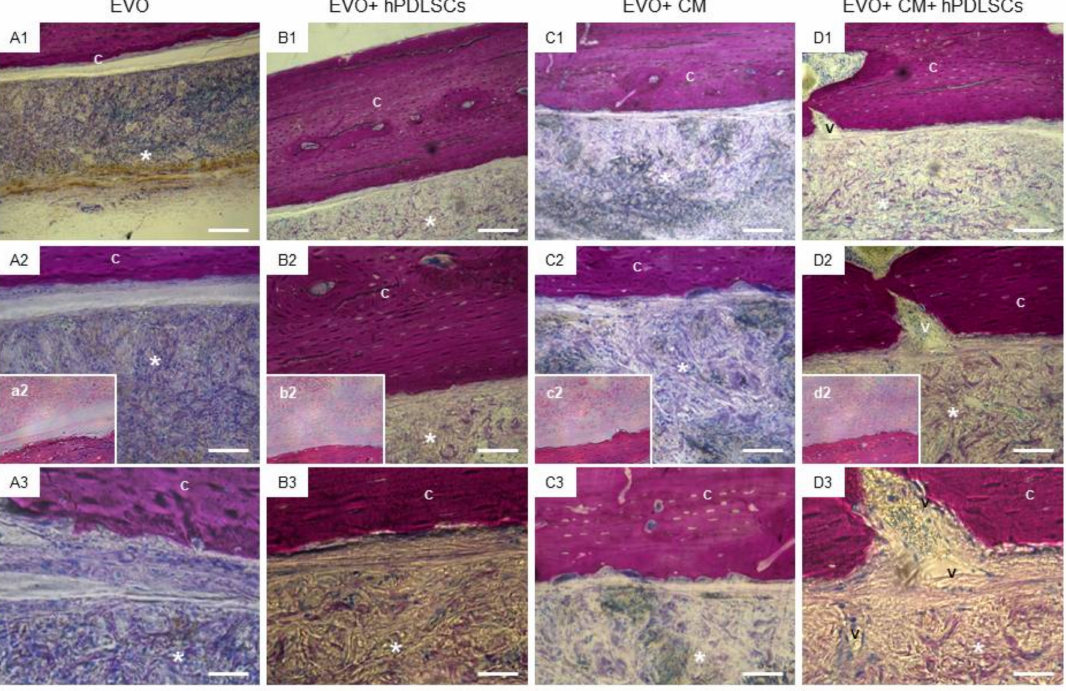
Figure 3. Histological examination. Representative methylene blue and acid fuchsine stained section images. ( A1 – A3 ) EVO group. ( B1 – B3 ) EVO + hPDLSCs group. ( C1 – C3 ) EVO + CM group. ( D1 – D3 ) EVO + CM + hPDLSCs group. ( a2 – d2 ) Representative hematoxylin/eosin stained sections images. ( A1 – D1 ): Mag = 10 × . Scale bars = 200 µ m. ( A2 – D2 , a2 – d2 ): Mag = 20 × . Scale bars = 100 µ m. ( A3 – D3 ): Mag = 40 × . Scale bars = 50 µ m. *: EVO; C: rat calvaria; V: